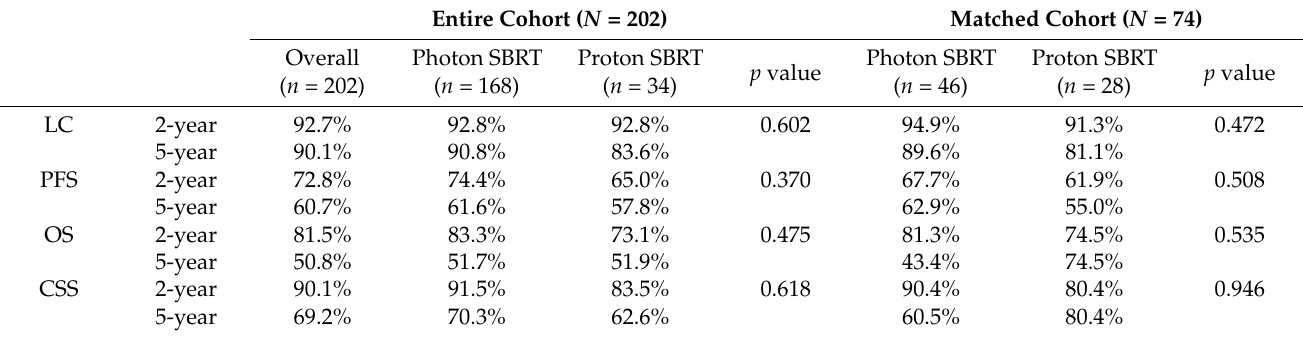
Table 2. Clinical outcomes of SBRT.